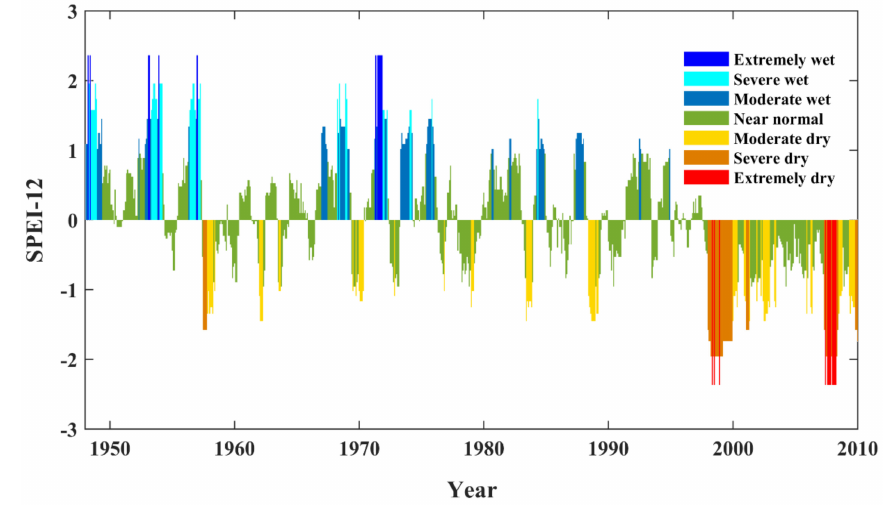
Figure 8. Time series of spatially averaged SPEI-12 over Iraq during